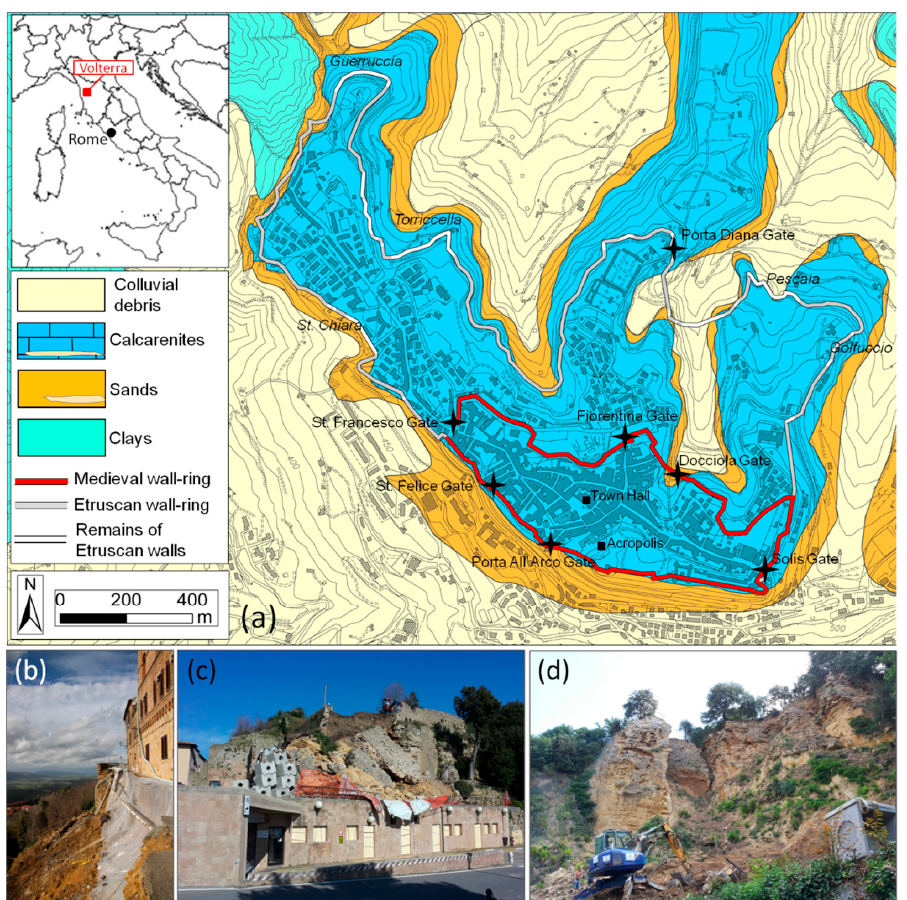
Figure 1. ( a ) Volterra study area: geological map and wall-ring; ( b ) January 2014 wall collapse; ( c ) March 2014 bastion collapse; ( d ) June 2014 slope failure.